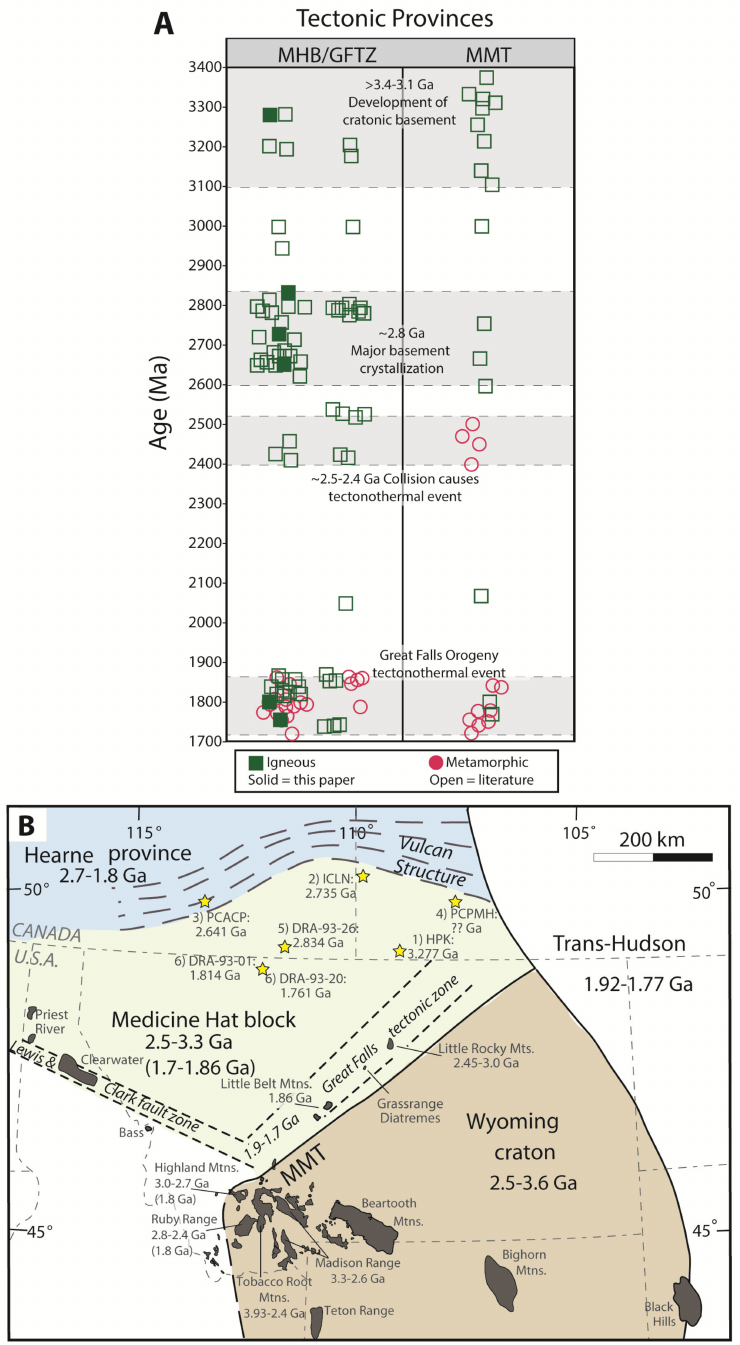
Figure 7. ( A ) Published Archean to Paleoproterozoic U-Pb ages of zircons from the Montana Metasedimentary terrane (MMT: Ruby Range, Tobacco Root Mountains, Madison Range, Highland Mountains:[32,49,94,95,106–108]).PublishedagesfortheMedicineHatblockandGreatFallstectoniczone (MHB / GFTZ: drill cores, Sweetgrass Hills xenoliths, Priest River Complex, Clearwater Complex, Little Belt Mountains, Little Rocky Mountains, Grassrange Diatreme xenoliths, this study; [4,5,56–59,95,98,99], all of which is being reported here. For reference, ages are plotted compared to U-Pb ages from this study. Ages interpreted as times of igneous crystallization are represented as squares, and